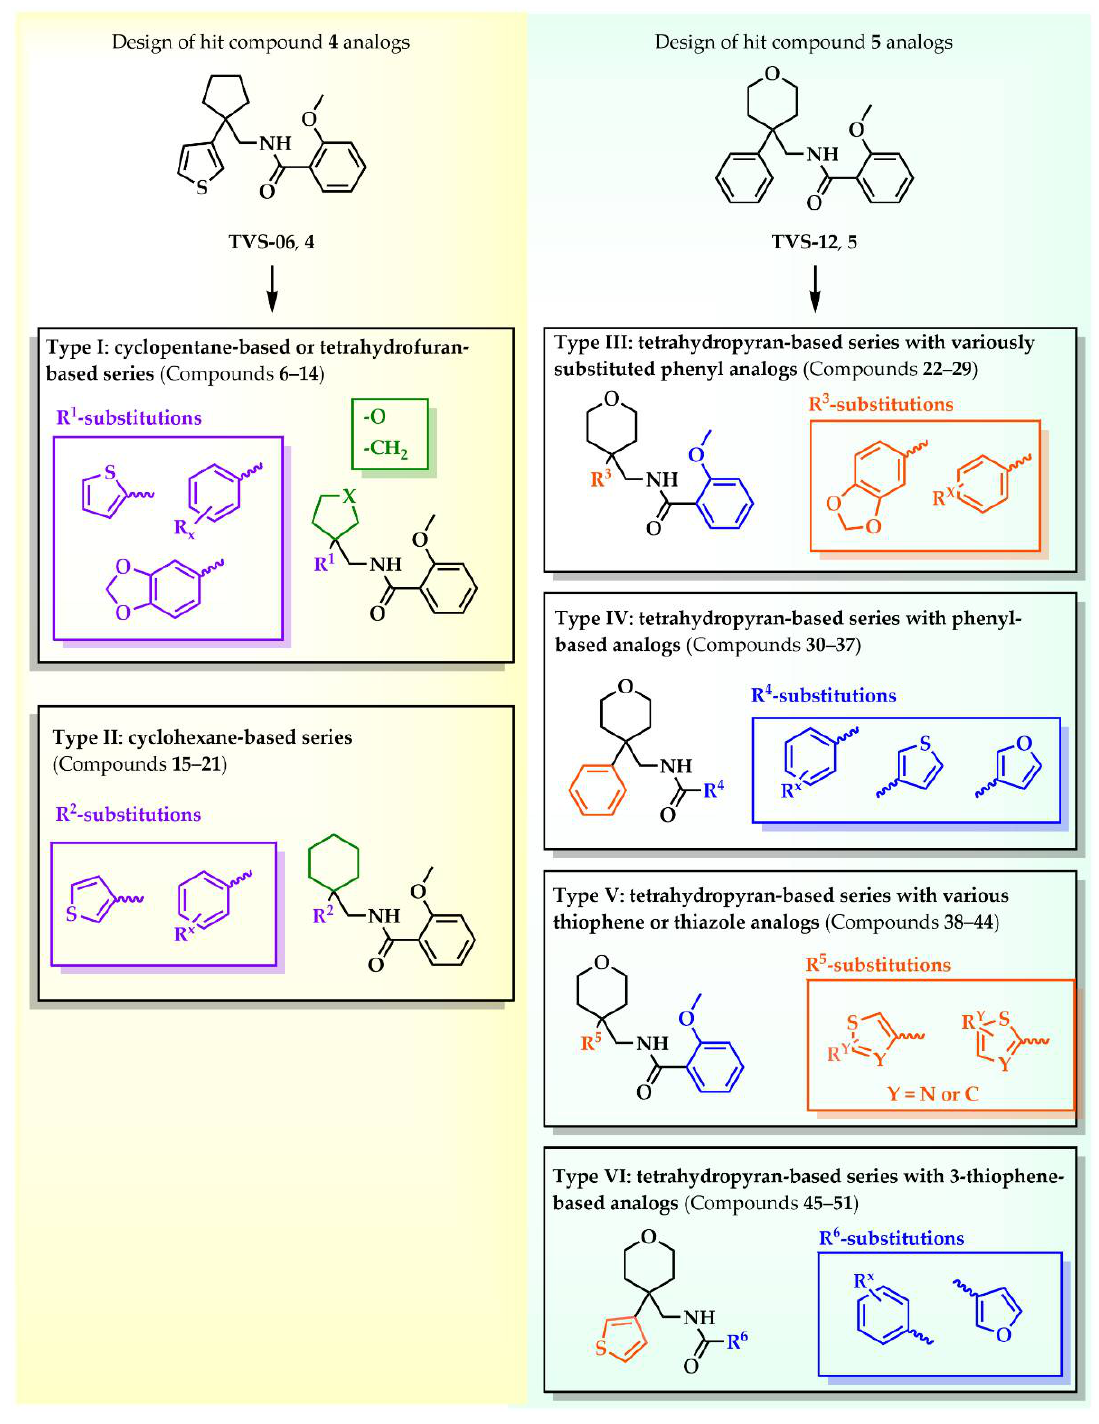
Figure 2. Design of new K V 1.3 inhibitors of structural Types I–VI.